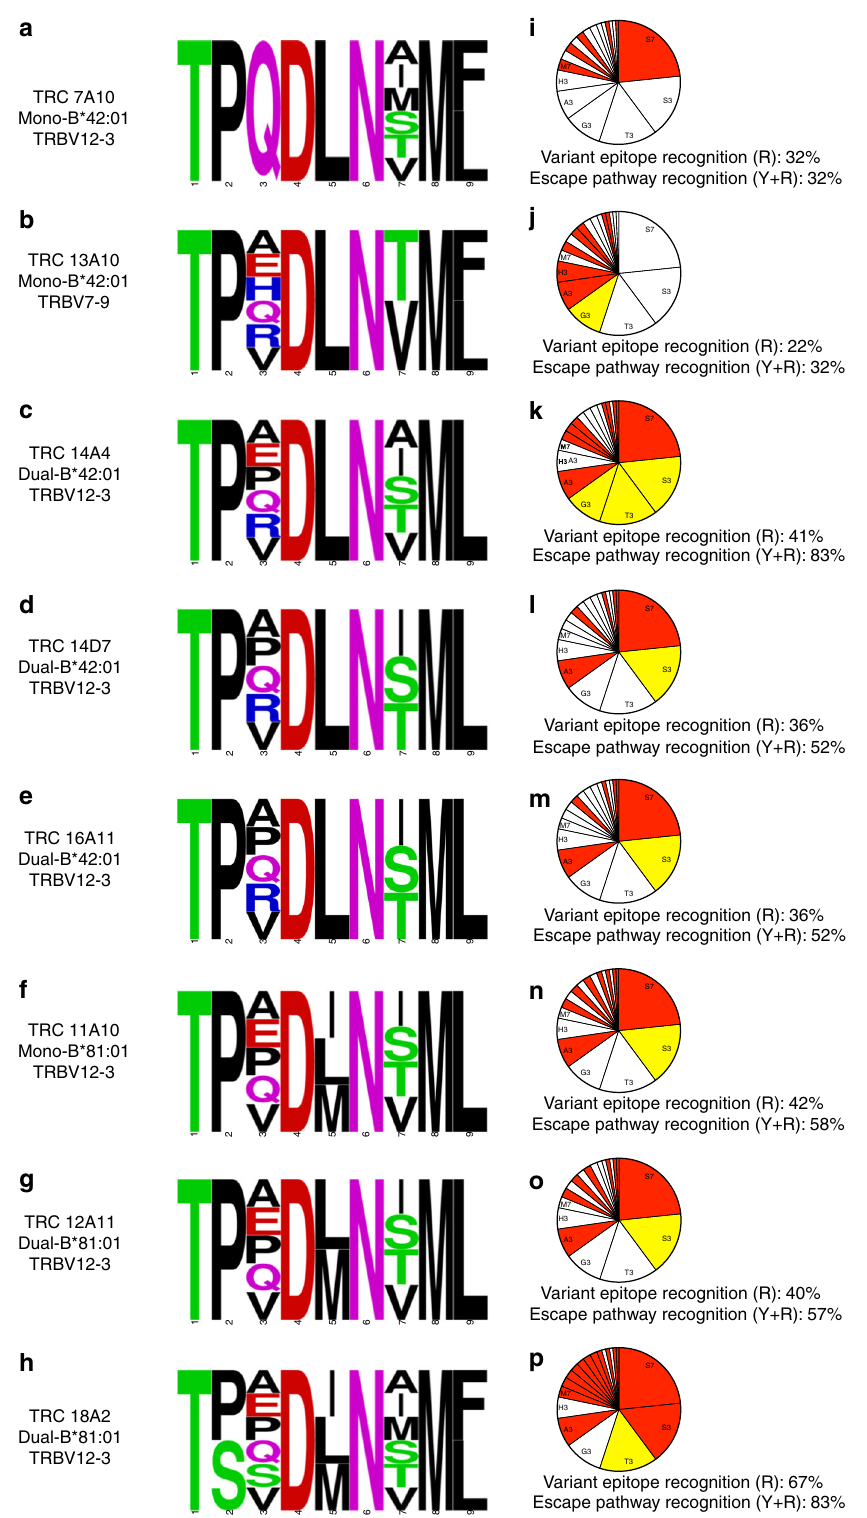
B*42:01 clones tended to display greater coverage (40 – 67% and 36 – 41%, respectively) compared to the mono-reactive B*42:01 clones (22 and 32%). These results indicate that individual TCR clonotypes display variable capacity to recognize more common TL9 variants that are likely to constitute preferential escape mutants.